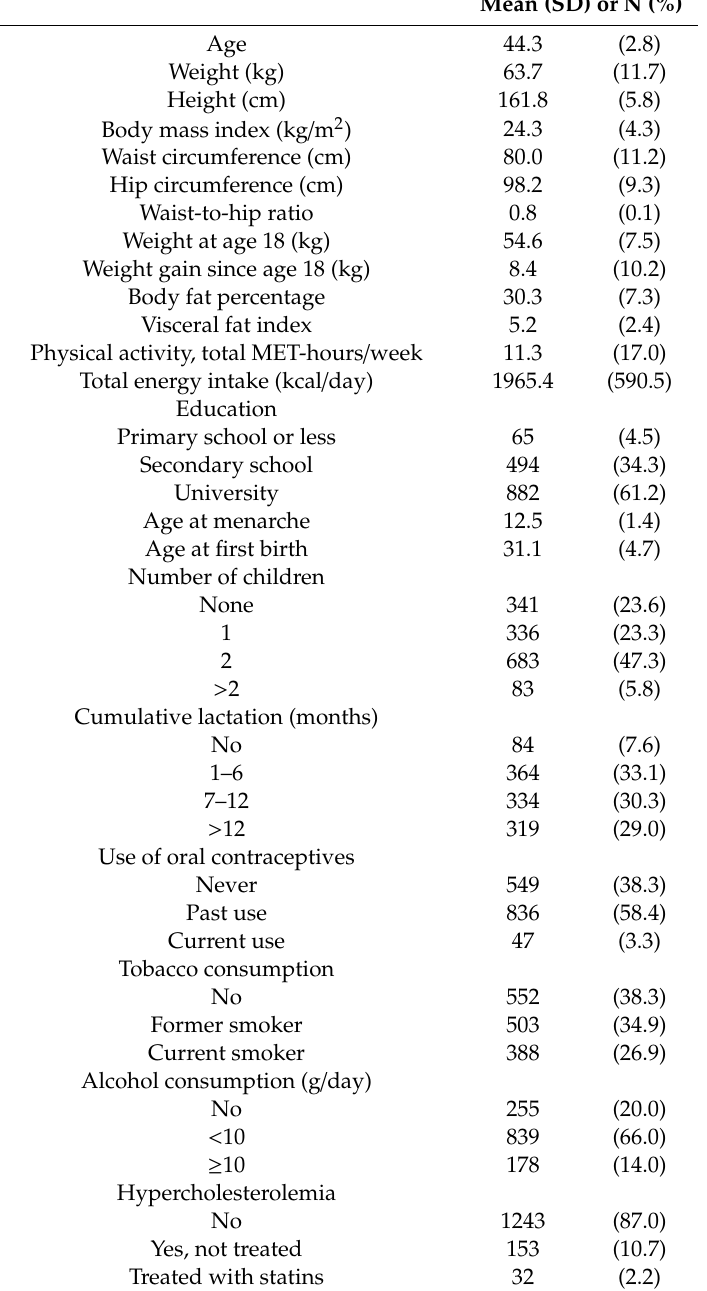
Table 1. Descriptive characteristics of the study